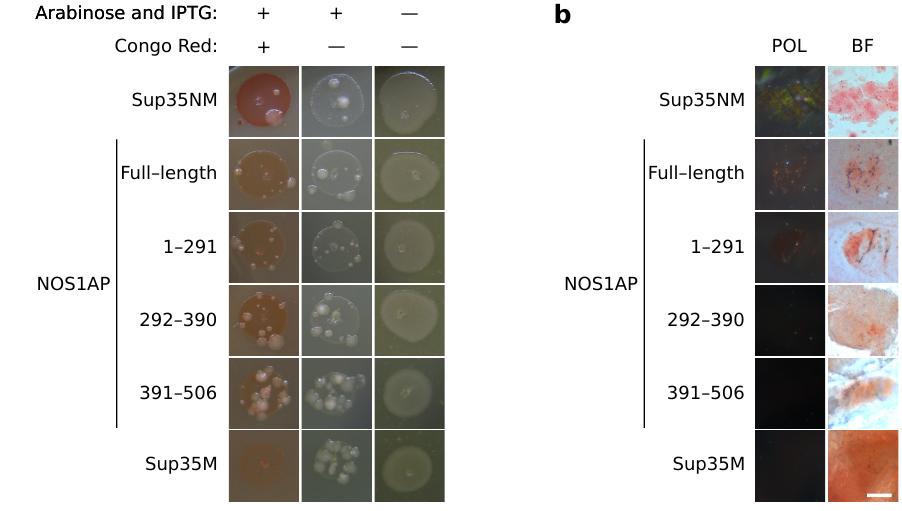
Figure 2. NOS1AP does not form amyloid aggregates in the C-DAG system. ( a ). Bacterial cells, overproduced NOS1AP, or its fragments possess the same color as negative control (Sup35M). The presence of Congo Red and inductors (arabinose and IPTG) are marked above the photographs. ( b ) The bacterial cells from Congo Red-containing media overproduced NOS1AP or its fragments do not demonstrate apple-green birefringence in polarized light. The microphotographs were obtained under transmitted (BF) and cross-polarized (POL) light. Scale bar equals 25 µm. Plasmids encoding Sup35NM and Sup35M were used as positive and negative controls,